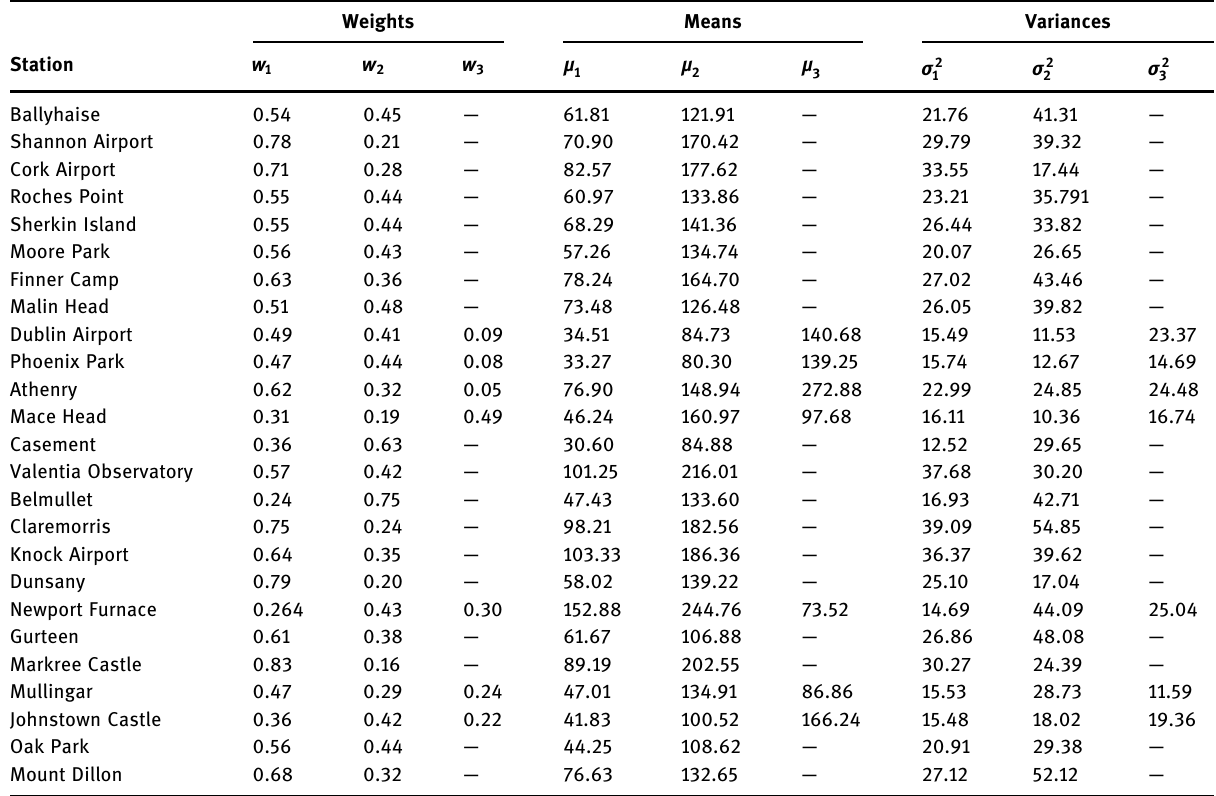
Table 3: Results of the best model selected by the model selection